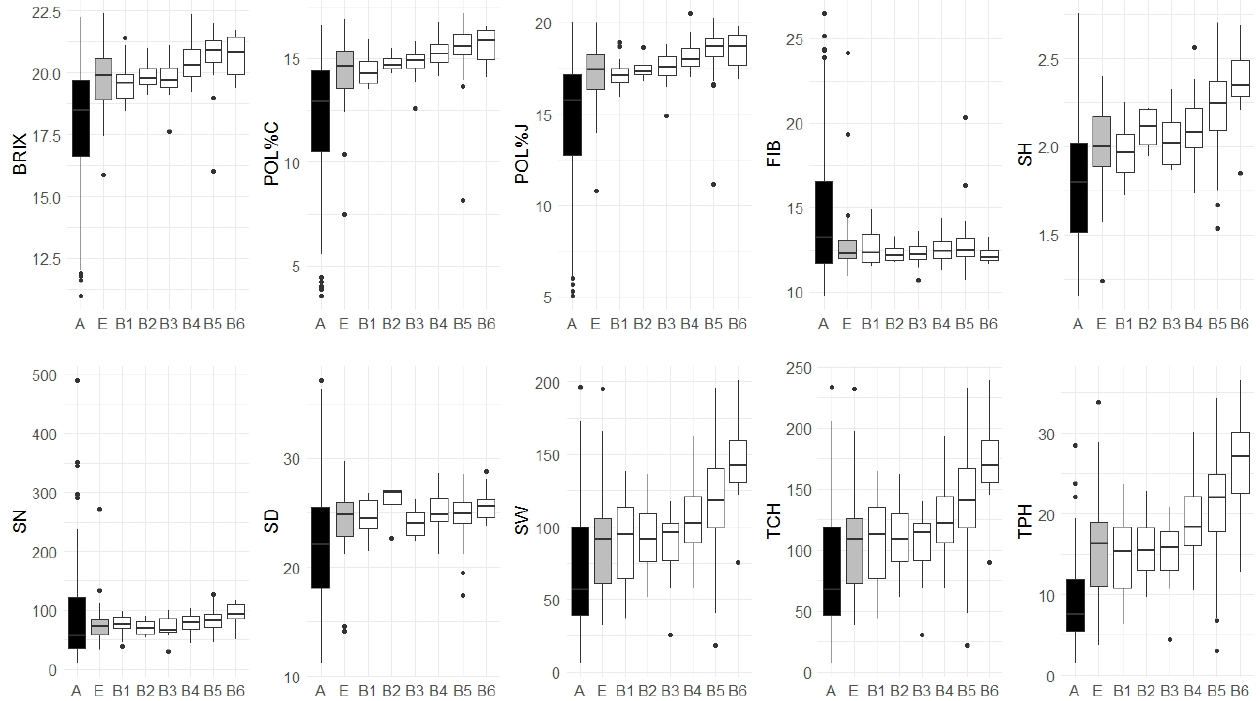
Figure 3. Boxplot analysis of yield traits (BRIX (in ◦ Brix), sucrose content of the cane (POL%C, in %), sucrose content of the juice (POL%J, in %), fiber content (FIB, in %), stalk height (SH, in m), stalk number (SN), stalk diameter (SD, in mm), stalk weight of the plot (SW, in kg), cane yield (TCH, in t/ha), and sucrose yield (TPH, in t/ha)) evaluated in the Brazilian Panel of Sugarcane Genotypes (BPSG). The accessions of BPSG were grouped into A (ancestors), E (foreign breeding accessions), and B (Brazilian breeding accessions). Group B was subdivided according to the decade in which the accession parents were crossed: B1 (1940 – 1951), B2 (1952 – 1961), B3 (1962 – 1971), B4 (1972 – 1981), B5 (1982 – 1991), and B6 (1992 – 2001). The boxplots of A, E, and B (B1, B2, B3, B4, B5, and B6) sets were black, gray, and white, respectively.